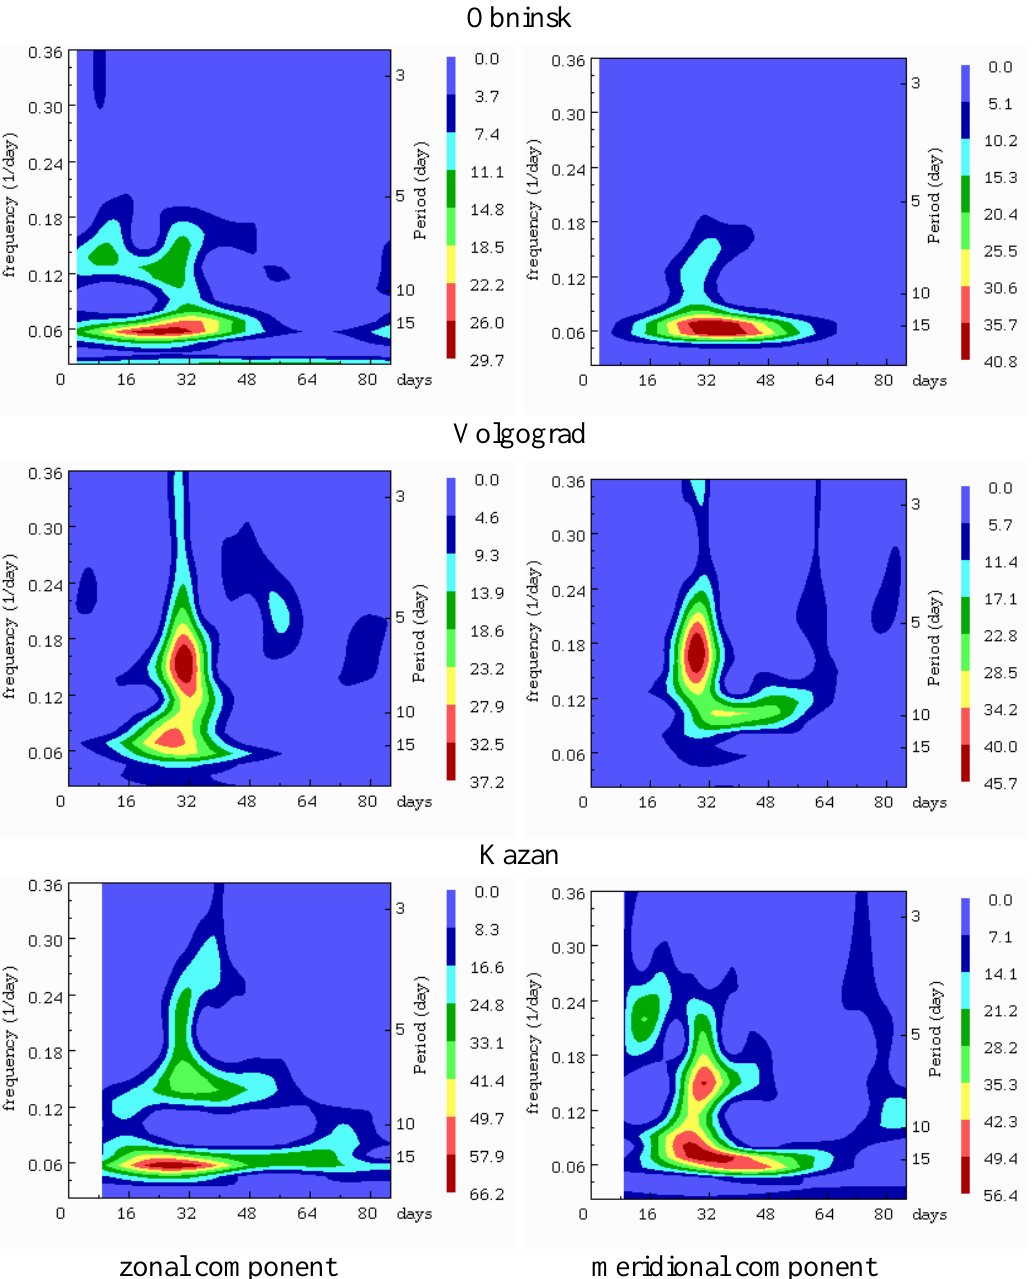
Fig. 1. S-transform spectrograms of semidiurnal tide amplitudes for the Eastern European sites. The days are numbered starting from 1 January 1990. The bar indicates values of squared amplitudes in m 2 s − 2